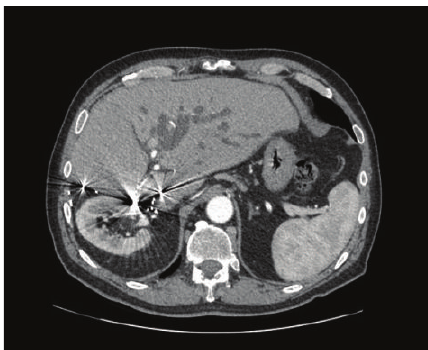
Figure 1: Axial contrast-enhanced CT displaying dilatation of the left hepatic duct due to an enlarging central metastatic